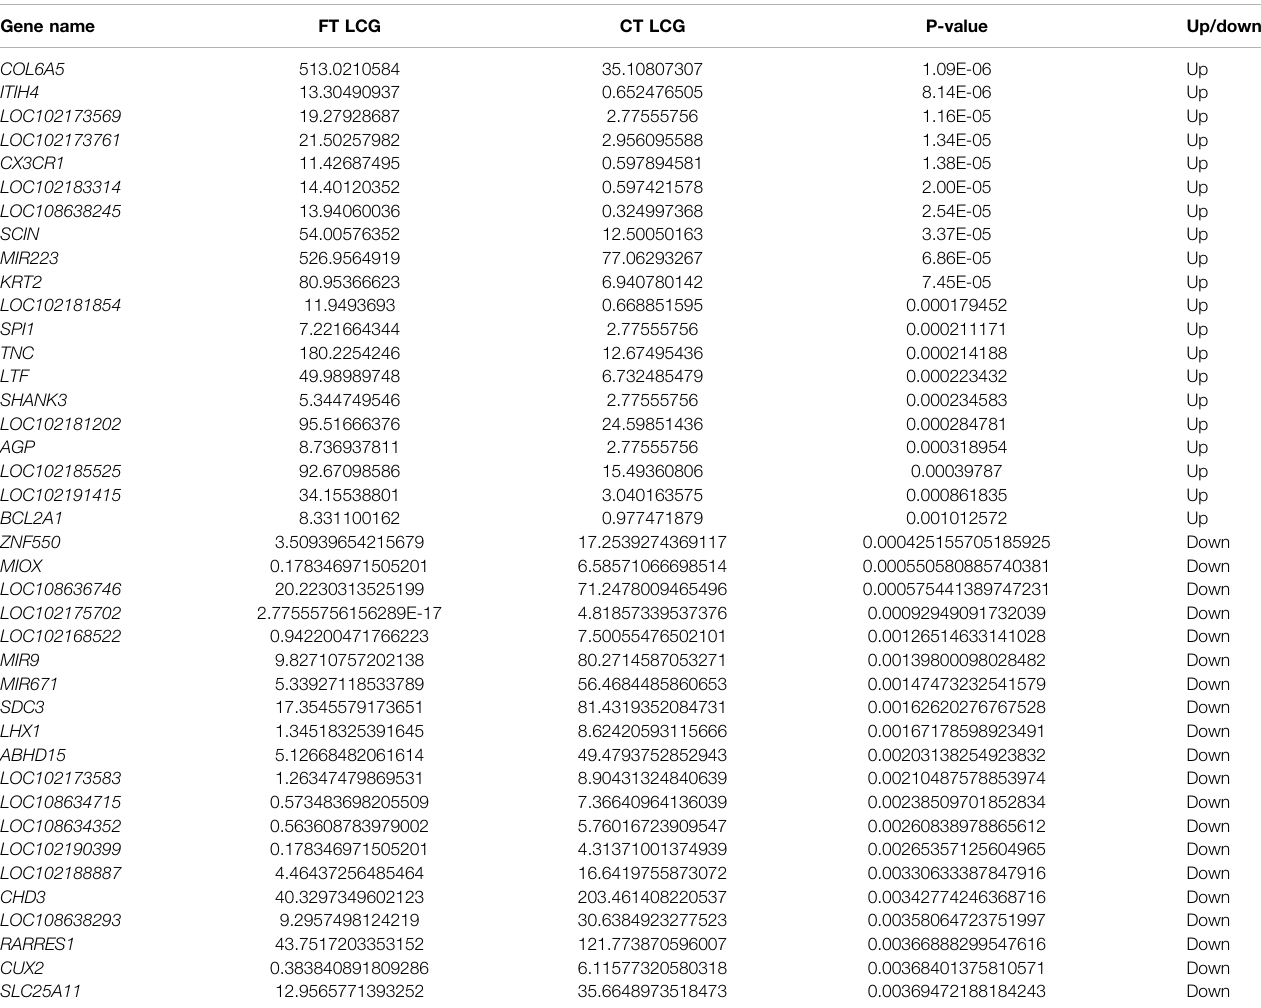
TABLE 3 | Partial up-down regulation difference gene table between fi ne type and coarse type